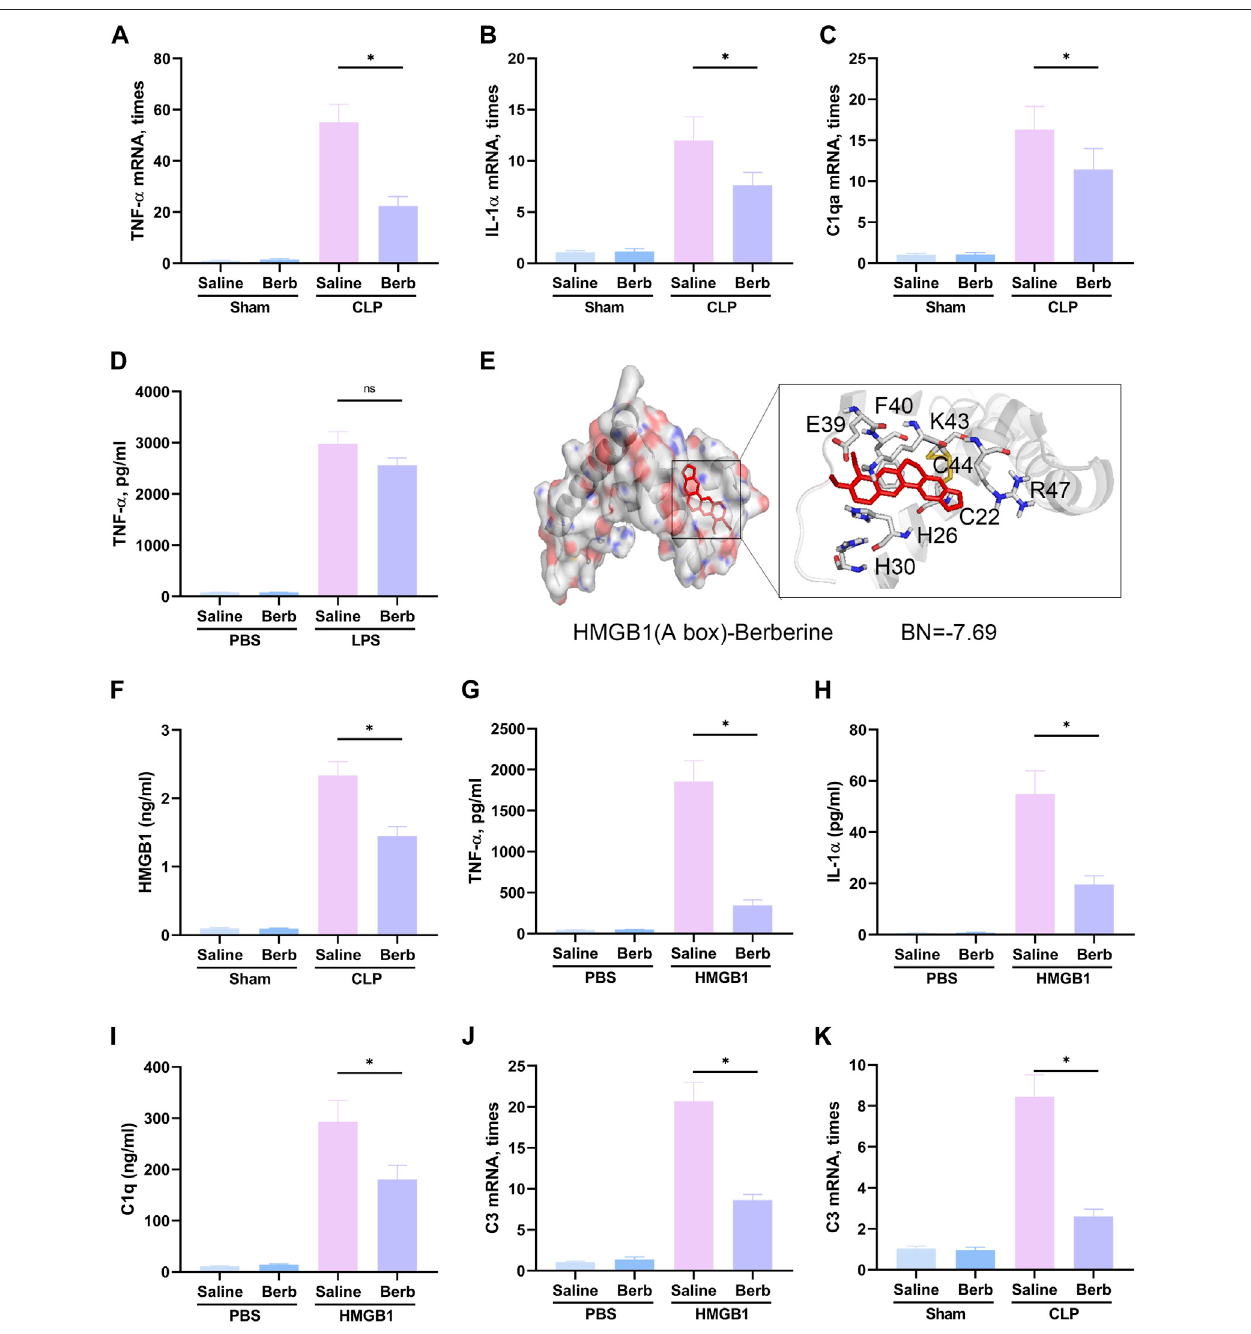
FIGURE 3 | Berberine inhibits microglia-stressed A1 astrocytes by inhibiting HMGB1 signaling. (A – C) . Expression of TNF- α (A) , IL-1 α (B) , and C1qA (C) in the hippocampus of mice administrated with saline or berberine (10 mg/kg) 30 min prior to a challenge of cecal ligation and puncture. (D). Medium level of TNF- α in the microglia treated with beriberine (5 μ M) or saline prior to a challenge of LPS (1 μ g/ml) or not. (E) . Binding of berberine and HMGB1 in the analysis of molecular docking. (F) .PlasmalevelsofHMGB1inmiceadministratedwithsalineorberberine(10 mg/kg)30 minpriortoachallengeofcecalligationandpuncture. (G – I) .Mediumlevel ofTNF- α (G) ,IL-1 α (H) ,andC1q (I) inthemicrogliatreatedwithberiberine(5 μ M)orsalinepriortoachallengeofrecombinantHMGB1(400 ng/ml)ornot. (J) .Expression of C3 (an A1 astrocyte-speci fi c gene) in astrocytes co-cultured with microglia that were treated with beriberine (5 μ M) or saline prior to a challenge of recombinant HMGB1 (400 ng/ml) or not. (K). Expression of C3 in the hippocampus of mice administrated with saline or berberine (10 mg/kg) 30 min prior to a challenge of cecal ligation and puncture. * indicates p < 0.05 in the comparisons of saline-treated with berberine-treated groups.